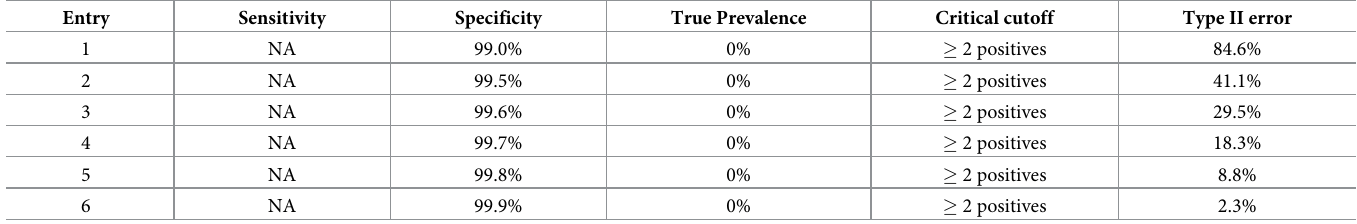
Table 3. Effect of specificity on the Type II error of a cluster survey involving 20 villages, and 50 people/village. No sensitivity assumptions were made. The critical cutoff was � 2 positive tests in at least 1 village. The calculations were made for a true prevalence of 0%. At least 99.8% specificity is required to reach a Type II error of < 10%.